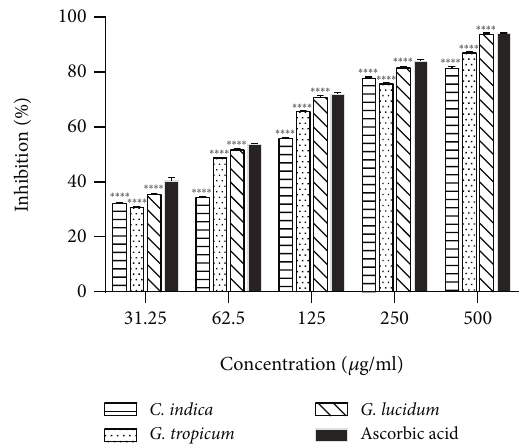
Figure 2: DPPH radicals scavenging e ff ects of various ethanolic mushroom extracts in comparison with ascorbic acid. Results are expressed as mean ± SD ( n = 3 ). ∗∗∗∗ p < 0 : 0001 vs. standard (ascorbic acid) at each concentration.